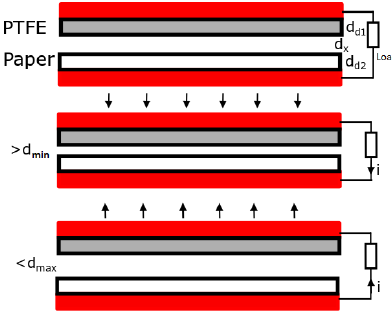
Figure 2. Triboelectric